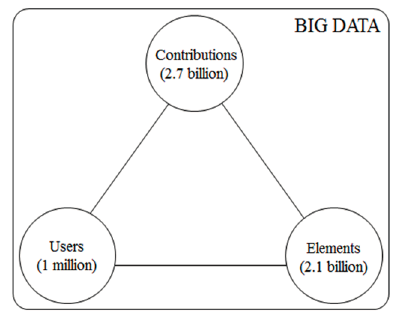
Figure 2. Three aspects of the study in the context of big